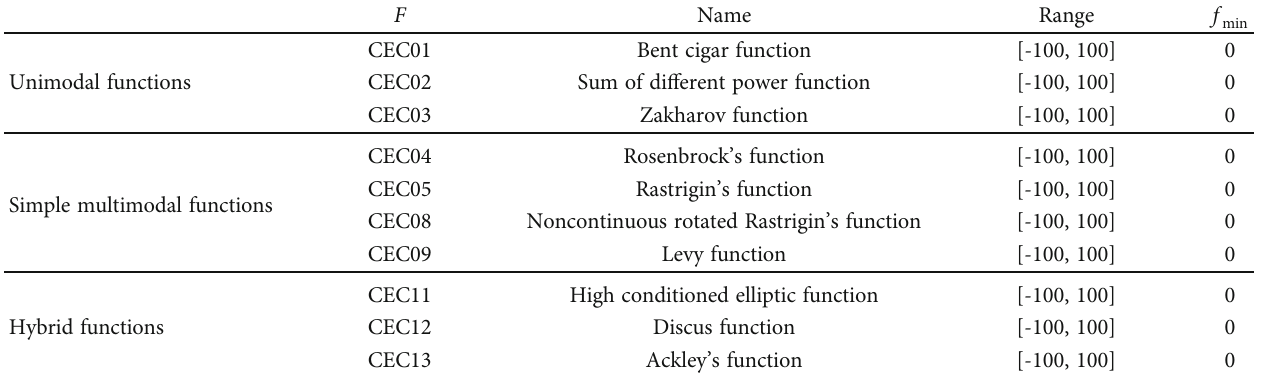
Table 10: CEC2017 test function.